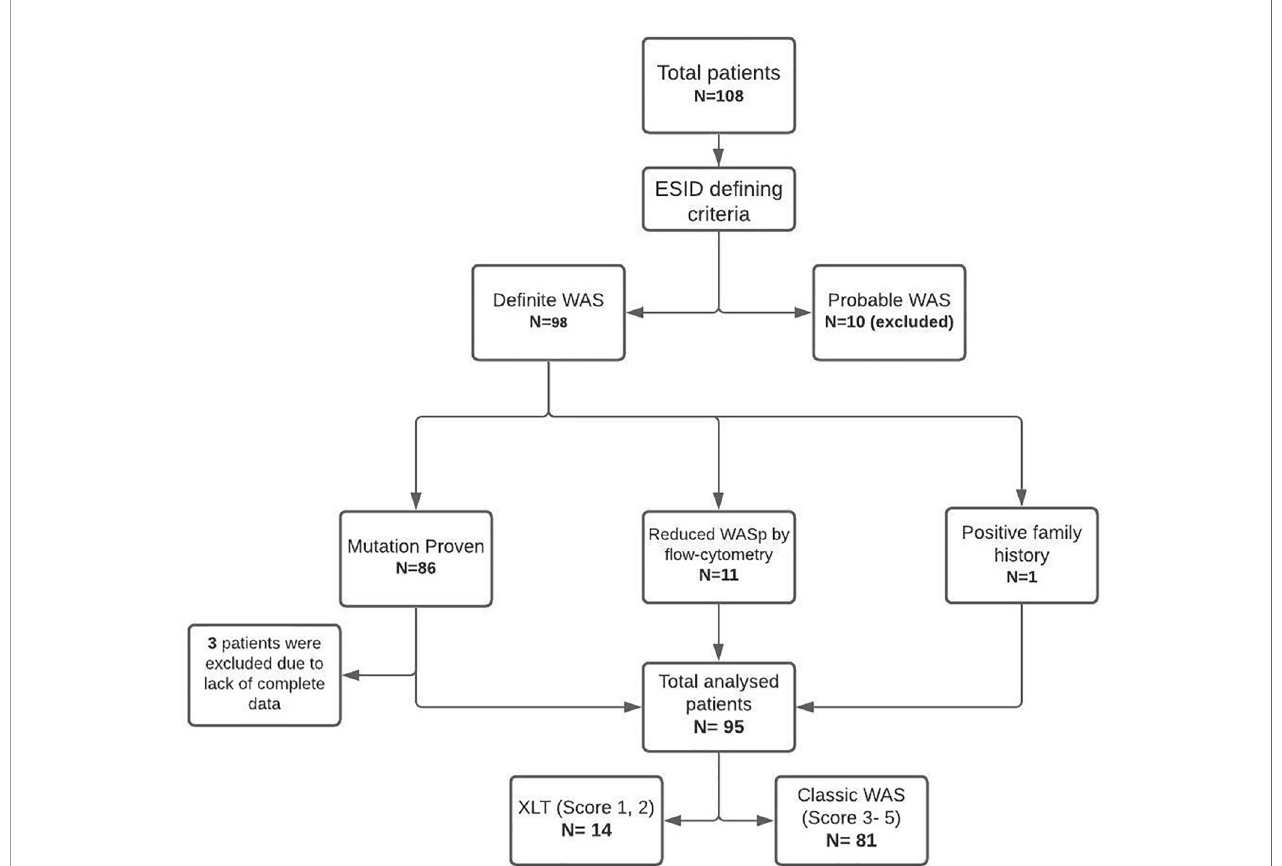
FIGURE 1 | STROBE diagram of collated data, strati fi cation and inclusion of study